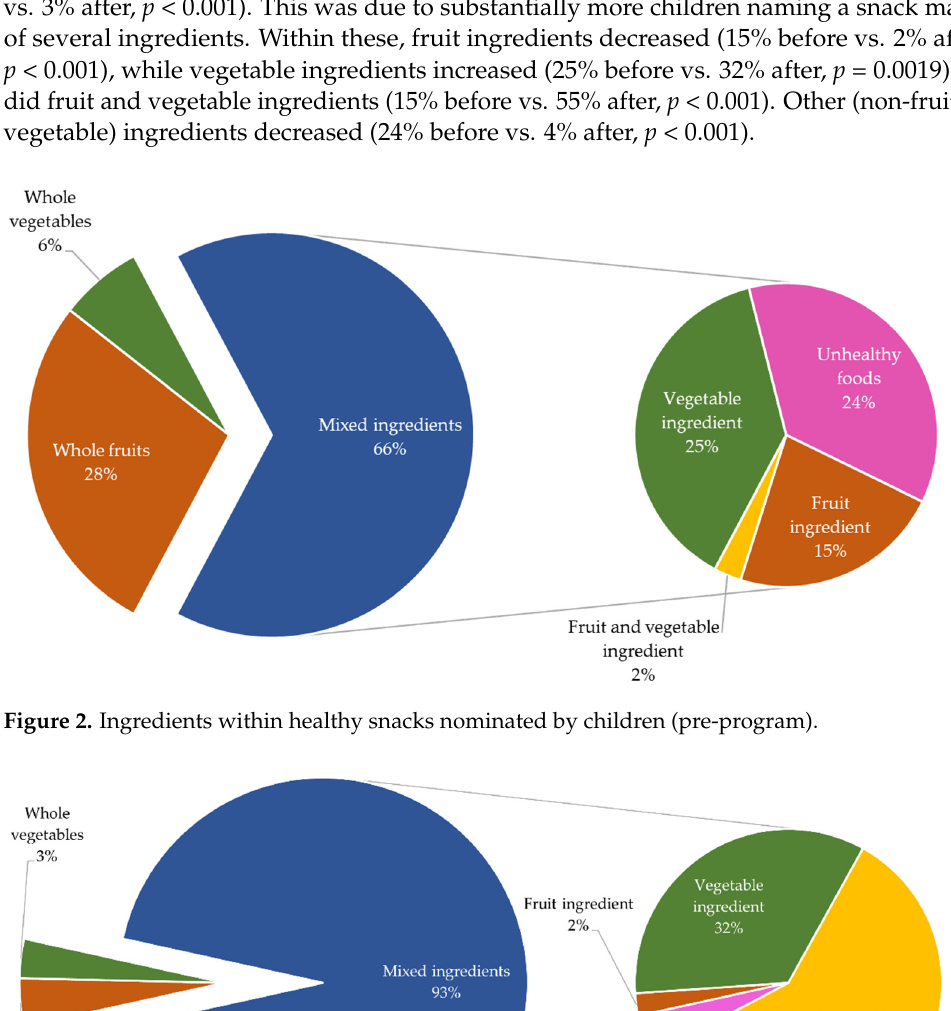
Figure 3. Ingredients within healthy snacks nominated by children